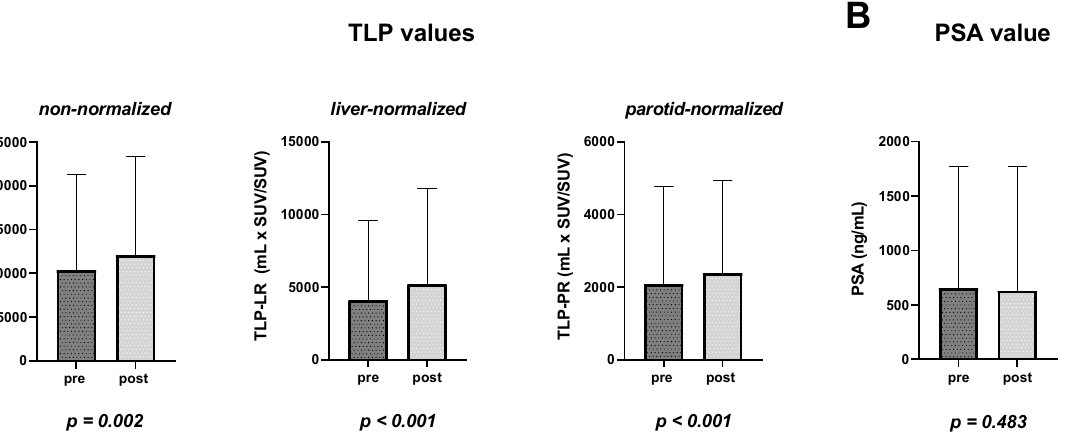
Figure 2. ( A ) Non-normalized total lesion PSMA (TLP), liver-normalized TLP (TLP-LR), parotid- normalized TLP (TLP-PR); ( B ) prostate-specific antigen (PSA) serum levels pre- and post- enzalutamide medication.